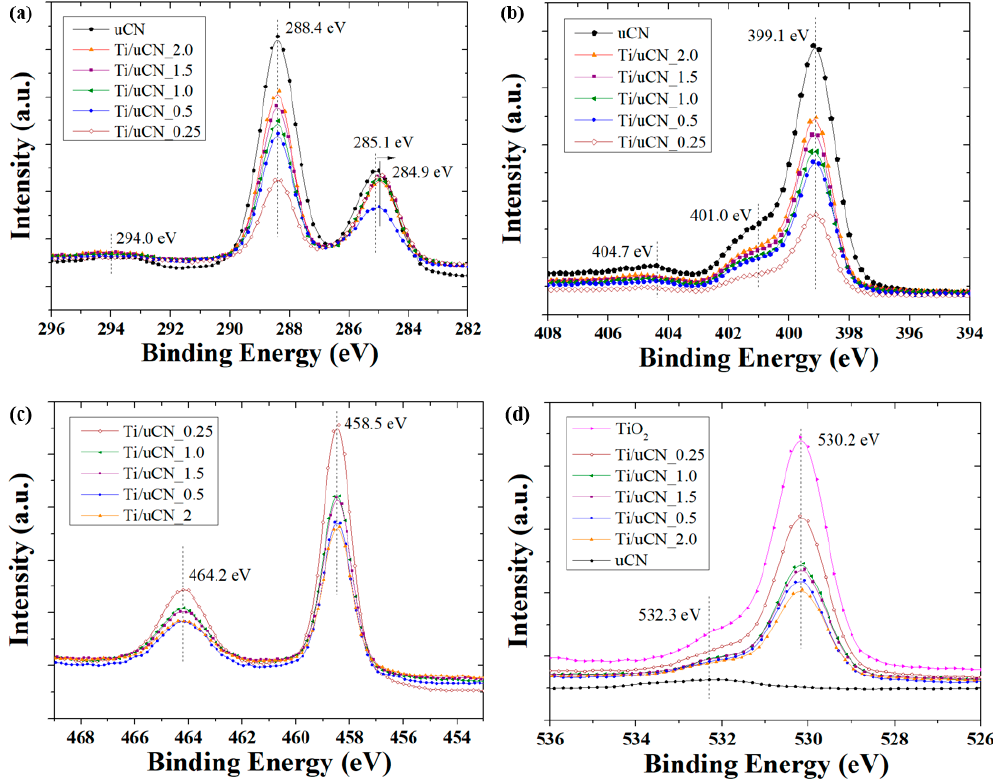
Figure 8. XPS spectra of uCN and Ti/uCN_x samples in: ( a ) C1s; ( b ) N1s; ( c ) Ti2p; and ( d ) O1s regions.